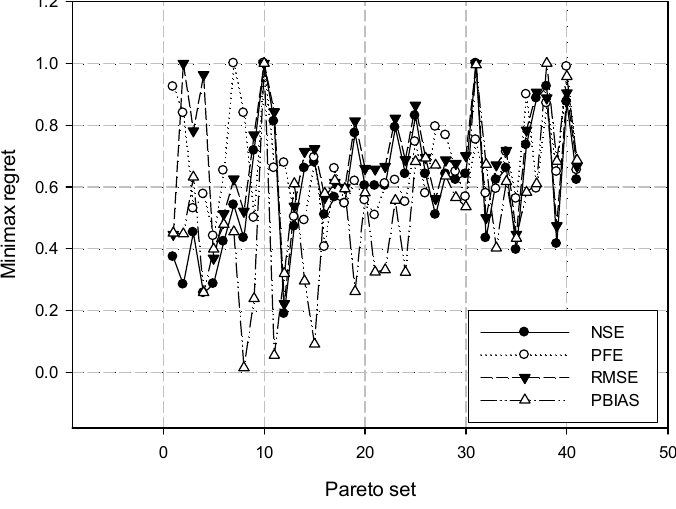
Figure 8. Values of four performance measures using minimax